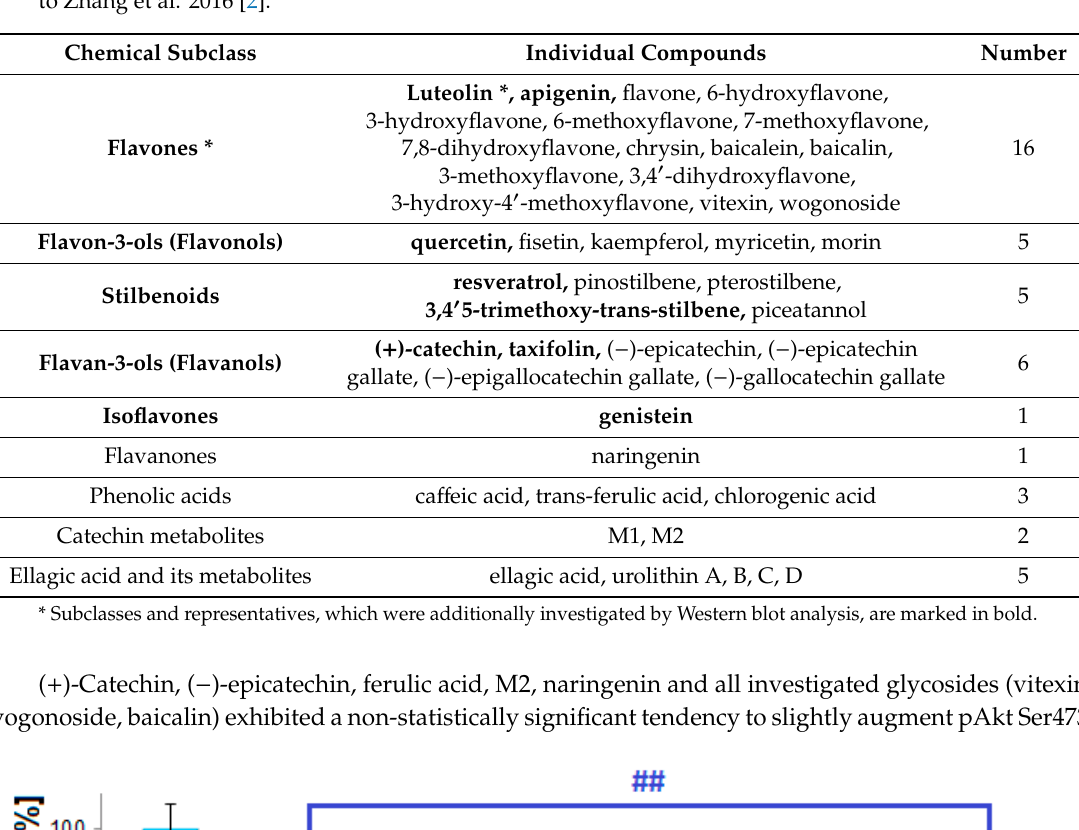
Table 1. List of polyphenolic compounds and intestinal microbiota-generated metabolites included in the screening regarding their effects on phosphorylation of Akt at Ser473 site. Classification according to Zhang et al. 2016 [2].